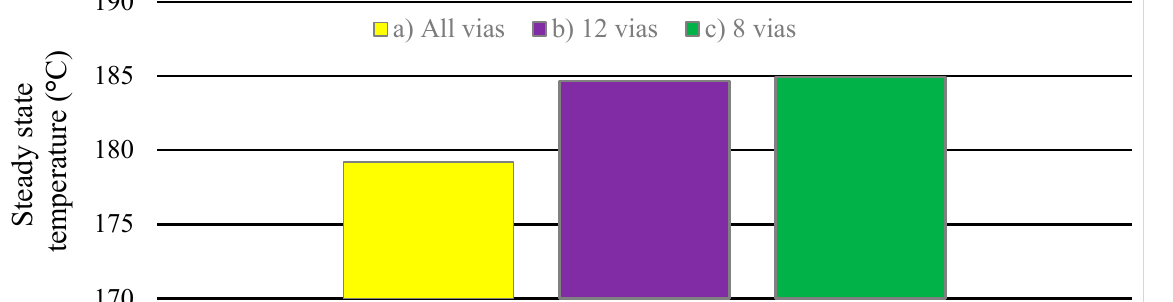
Figure 13. The temperature change process after the start of the converter with the power of 700 W. Simulation of the cases with 40, 12, and 8 thermal vias.